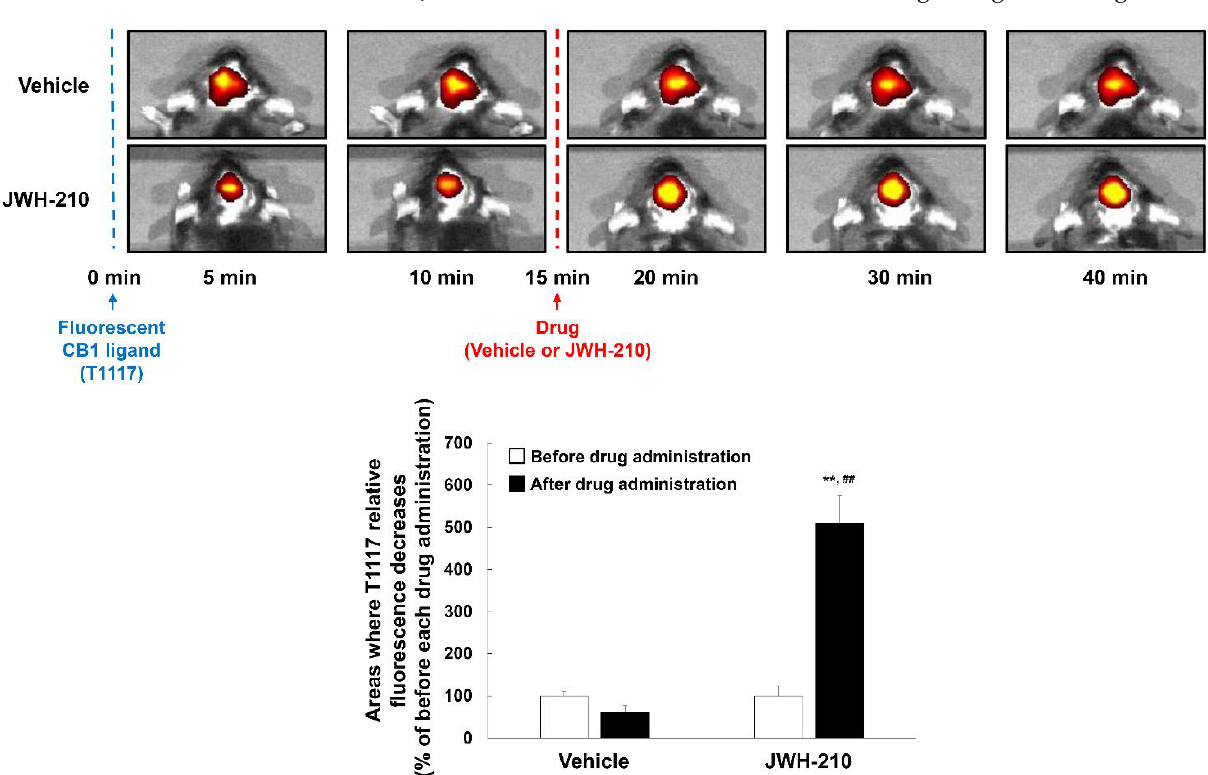
Figure 1. Displacement of fluorescent CB1 ligand binding in vivo by JWH-210. CB1 ligand (T1117; 10 μL, 5 mM in DMSO, i.c.v) was administered 15 min before JWH-210 (0.1 mg/kg, i.p.). Arrows indicate fluorescent CB1 ligand and drug (vehicle or JWH-210) injection time (0 and 15 min, respectively). Data are expressed as the mean ± S.E. ( n = 2–3) and were analyzed using two-way ANOVA followed by Bonferroni post-hoc t-test (** p < 0.01 vs. each before drug administration group; ## p < 0.01 vs. Vehicle/After drug administration group). I.C.V.: intracerebroventricular injection. I.P.: intraperitoneal injection.